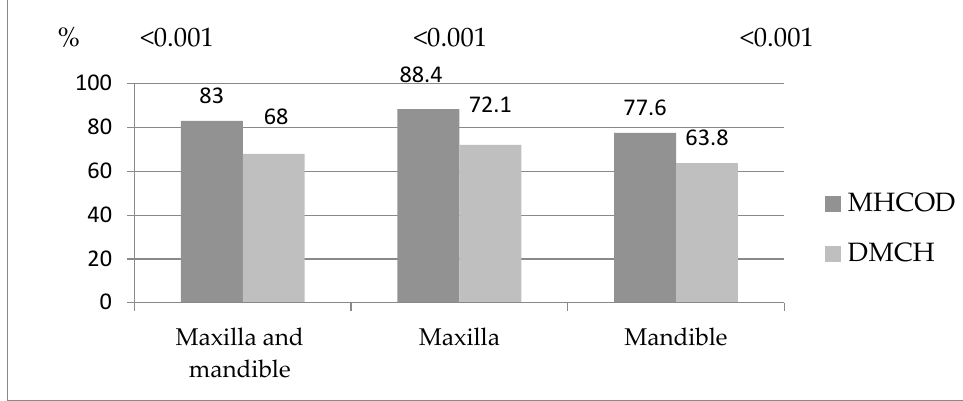
Figure 1. Distribution of missing teeth between the study groups.